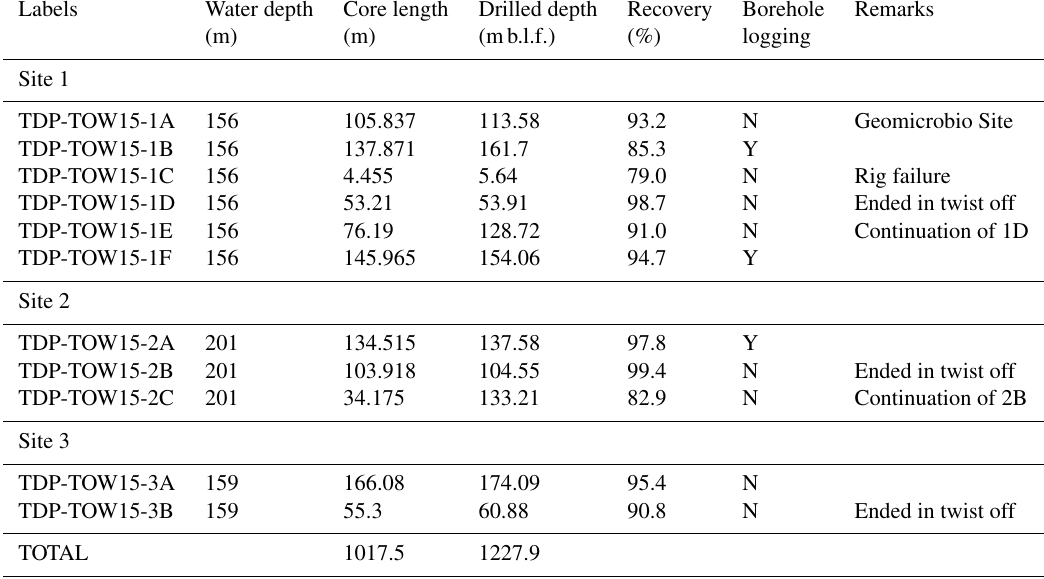
Table 1. Summary information about TDP drill sites. Drilled depth indicates the bottom depth of each hole; % recovery indicates the meters of core recovered within the depth intervals where coring was attempted, and thus excludes intervals drilled with a non-coring assembly. Labels Water depth Core length Drilled depth Recovery Borehole (m) (m)